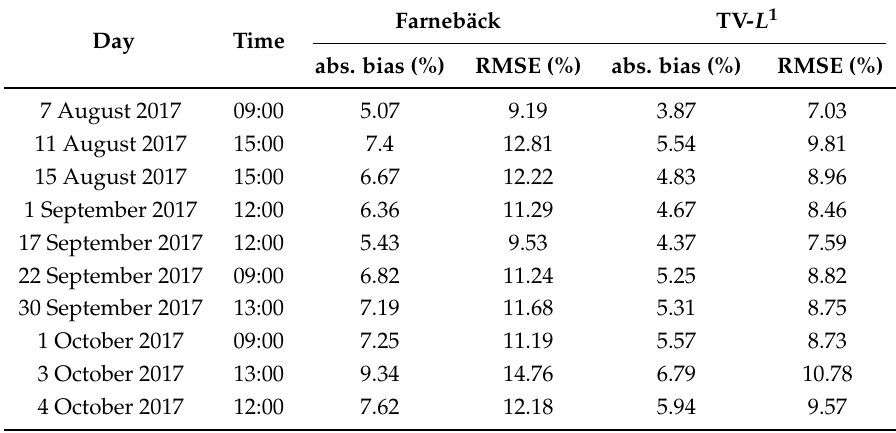
Figure 3. Plots of the verification of the optical flow estimate with the method by Farnebäck (left) and the TV- L 1 method (right) for a 15-min forecast. The area of Germany is marked by the red frame. Table 1. Calculated absolute bias and RMSE for both optical flow methods, the one by Farnebäck and with TV- L 1 . The error measures were calculated for a 15-min forecast over the area of Europe. These are 10 exemplary cases because the superiority of TV- L 1 can be clearly seen already, and these values are sufficient to see the difference between the performance of the